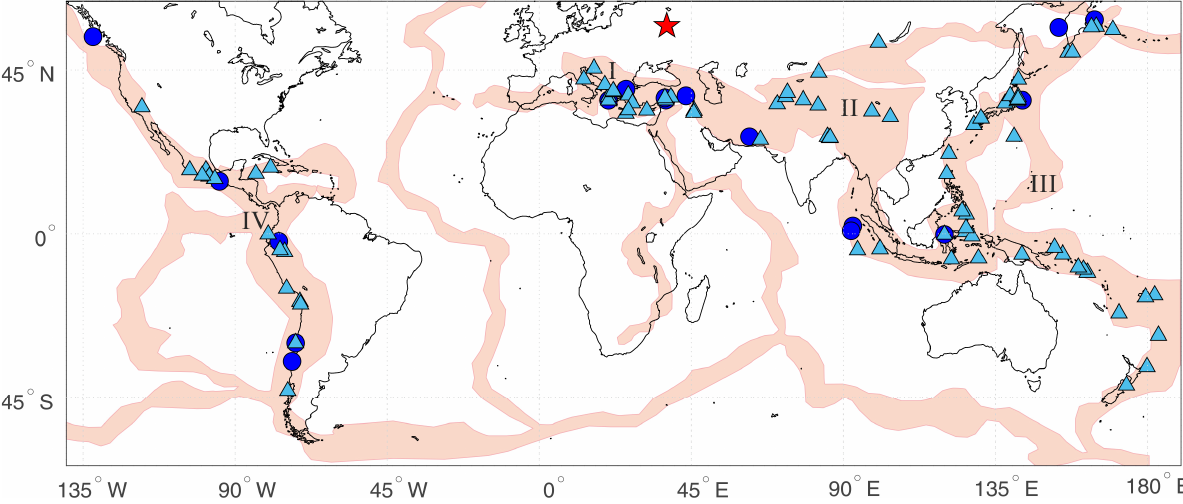
Figure 6. Map with earthquake locations, which were recorded at the Mikhnevo observatory (red star) in the water level variations of the WLC (deep blue circles) and WLU (light blue triangles) aquifers. Seismic belts: I—Mediterranean, II—Trans ‐ Asian, III—West Pacific, IV—East Pacific.